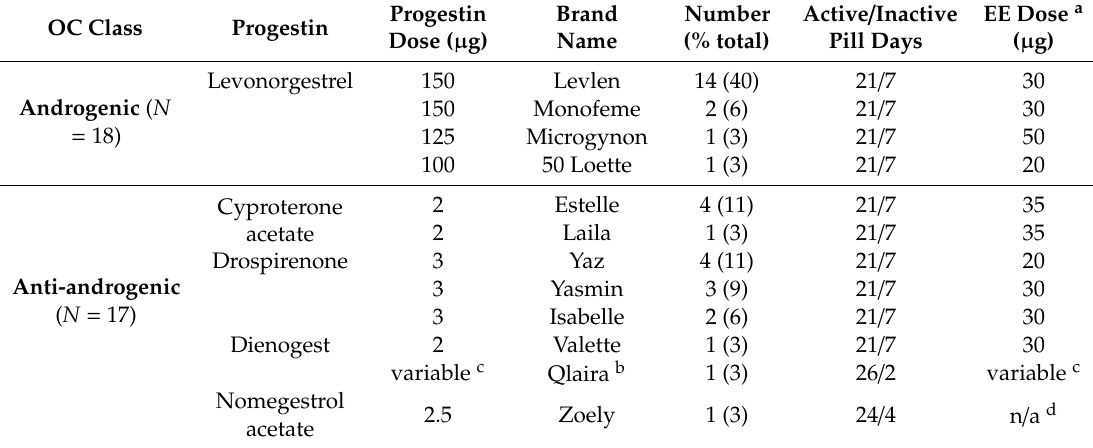
Table 2. List of oral contraceptive medication formulations taken by the 35 participants in the study cohort, divided into androgenic and anti-androgenic groups